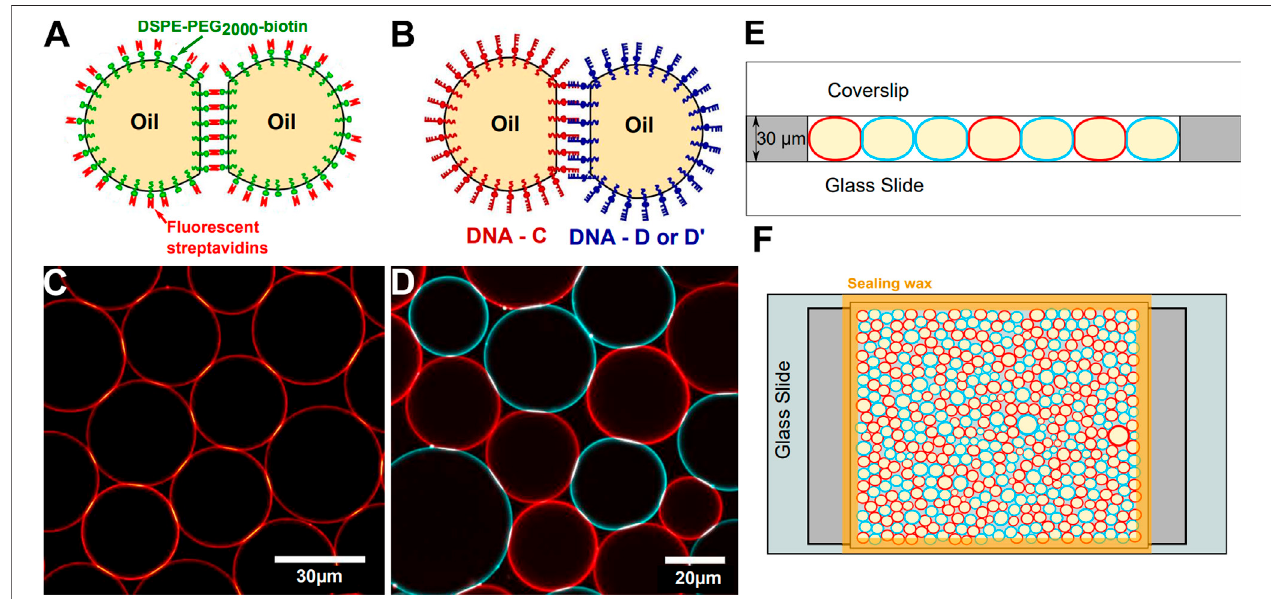
FIGURE 1 | Experimental setup — Sketch of adhesive droplets functionalized with streptavidin (A) or DNA binders (B) . (C) Confocal image of a 2D packing of droplets stabilized with fl uorescent streptavidin. (D) Confocal image of a 2D packing of droplets functionalized with C and D DNA sequences labelled respectively with Alexa Fluor-555 (red) and -488 (blue) streptavidins. In (C, D) , brighter patches at droplet-droplet junctions denote adhesion patches enriched in fl uorescent binders. (E) Side-viewoftheexperimentalchamber, (F) SketchofatopviewoftheexperimentalchambercontainingapackingofcomplementaryDNA-functionalizeddroplets.